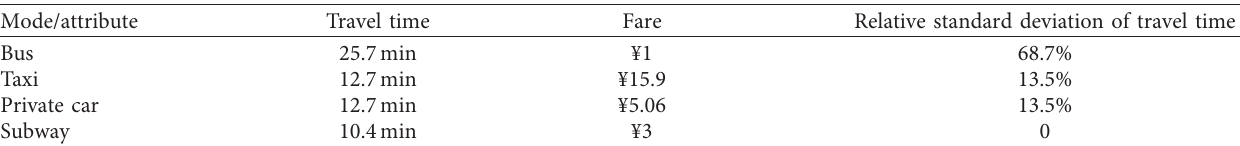
Figure 6: Relative feature importance of the four travel modes. (a) Bus. (b) Taxi. (c) Subway. (d) Private car. Table 4: Travel information of a short trip.